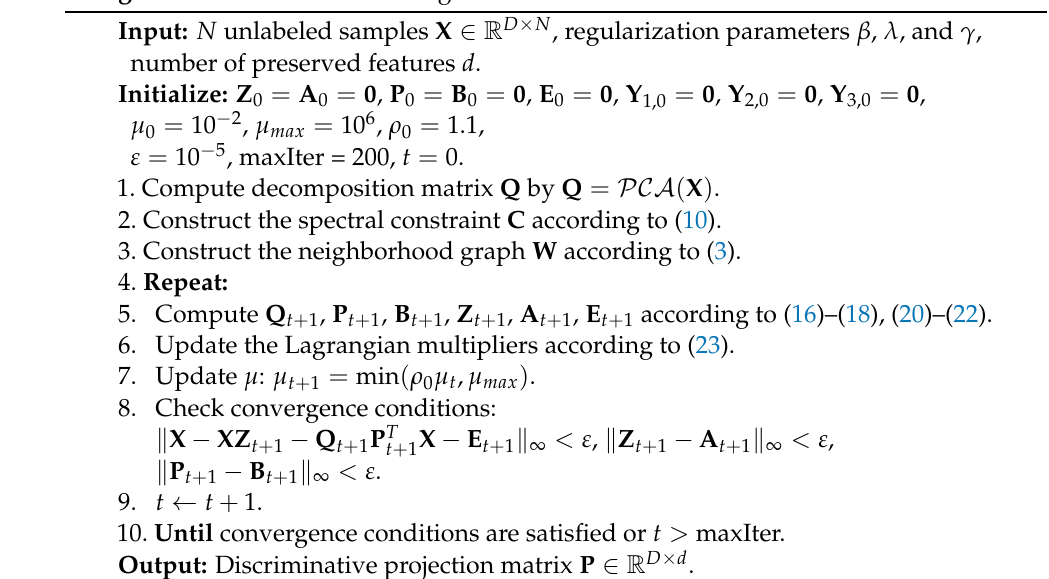
Algorithm 1: ADMM for solving